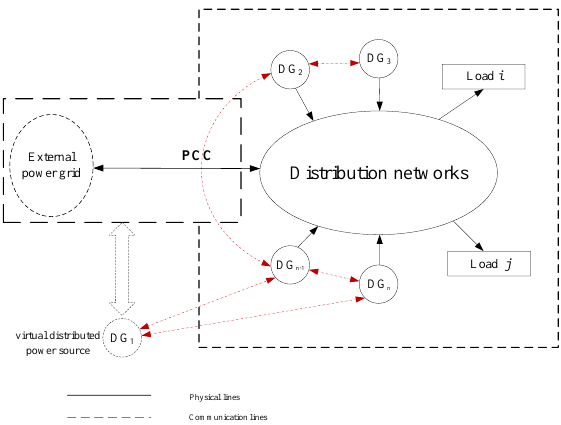
Figure 1. Active distribution network dispatch system.